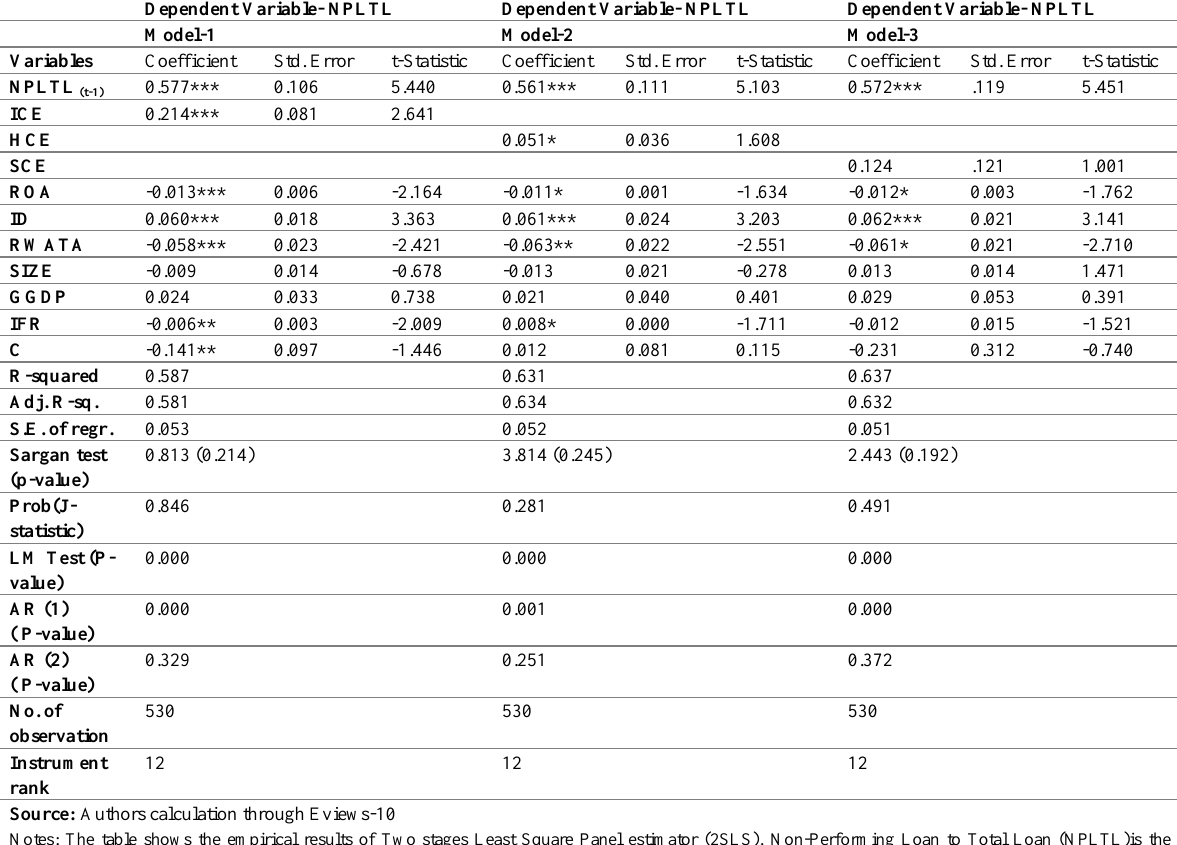
Table 5: Effects of IC Efficiency, HCE, SCE on credit